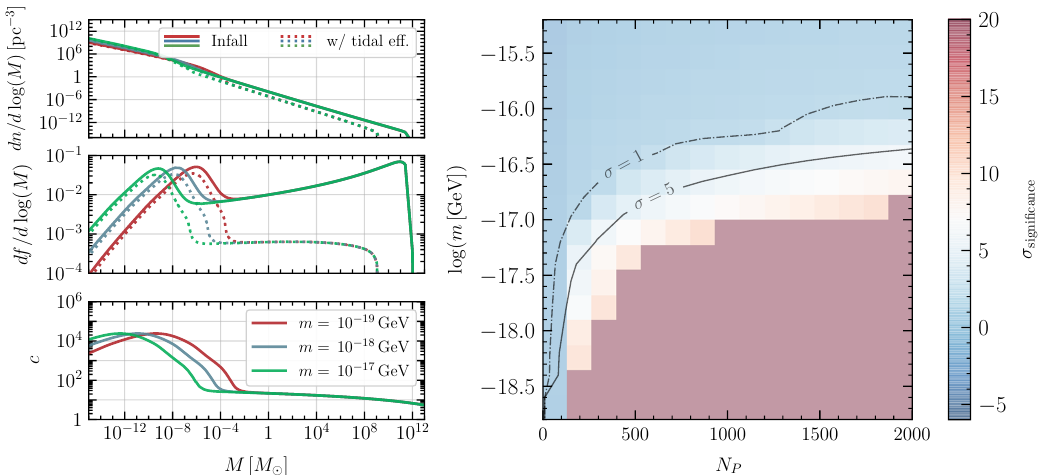
Figure 9 . Left : sHMF (top panel), and mass fraction per logarithmic mass interval (center panel) before (solid) and after (dashed) the inclusion of tidal effects. The lower panel shows the typical subhalo concentration parameter as a function of their mass. All curves are shown for three values of the DM mass, m = 10 − 17 , 10 − 18 , 10 − 19 GeV . Right : discovery significance for different values of the DM mass and number of pulsars in the array. The inflationary scale, H , has been fixed in order I to reproduce the DM relic density according to eq. (4.15). The residual timing noise, observation cadence, and observation time have being fixed to t = 10 ns , ∆ t = 1 week , and T = 30 yr . The rms dashed (solid) line shows the 1 σ ( 5 σ ) significance